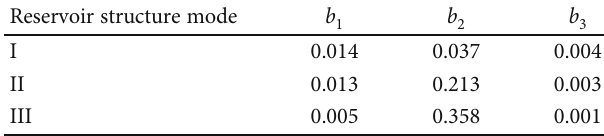
. k , a of Equation (7) in Akpo oil fi elds. 1 2